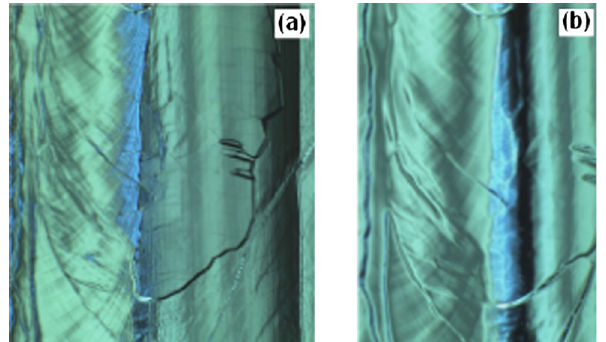
FIG. 17. Example of sharp grain boundary in AC158 after BCP treatment (a) and the same grain boundary smoothed by EP treatment